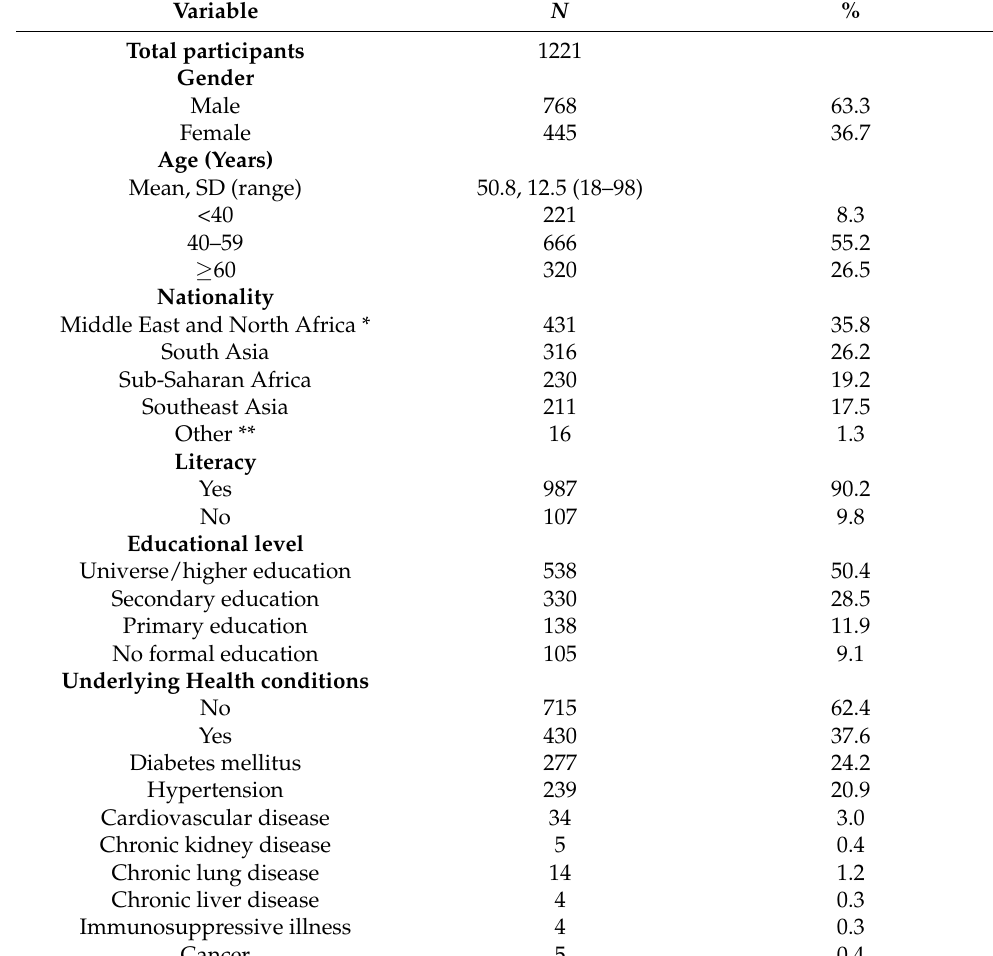
Table 1. Characteristics of the study population.